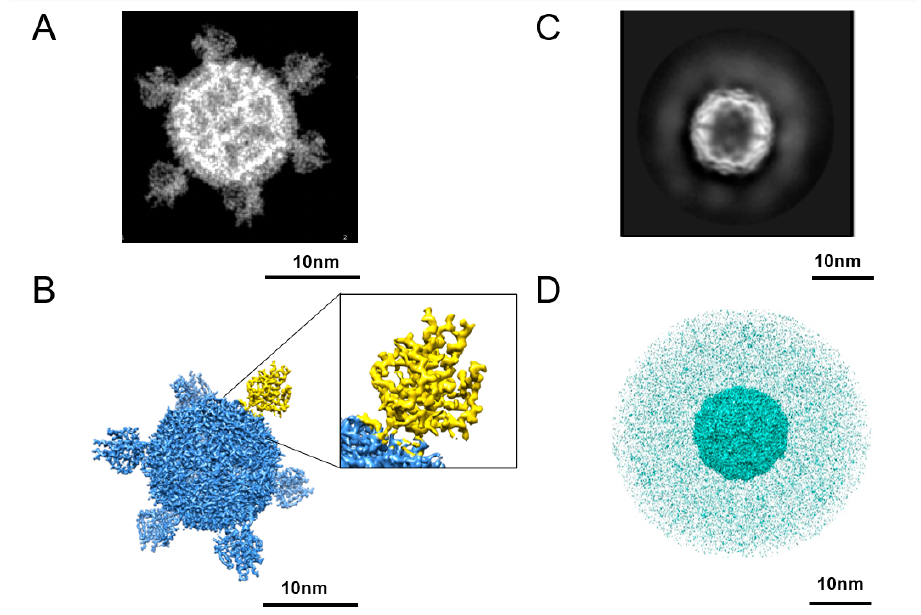
Figure 2. Cryo-EM characterization of head-only NadA_ferritin ( A , B ) and full-length NadA_ferritin ( C , D ). ( A ) 2D class average showing the icosahedral ferritin sca ff old decorated by eight NadA heads (only 6 of them are visible). ( B ) Reconstructed 3D map of the NadA-ferritin head structure at 4 Å of resolution with ferritin sca ff old and heads (in blue) and one of the heads in yellow. Close-up view of one NadA head showing the folding of residues composing the NadA head. ( C ) 2D class average of NadA-ferritin FL showing the icosahedral ferritin sca ff old correctly folded, decorated by blobs of densities corresponding to the highly fl exible and elongated stalk of the NadA homotrimers. ( D ) Reconstructed 3D map of full-length NadA_ferritin (in cyan) showing the inner ferritin sca ff old sur- rounded by a cloud of electron density generated by the fl exibility of the NadA stalks.